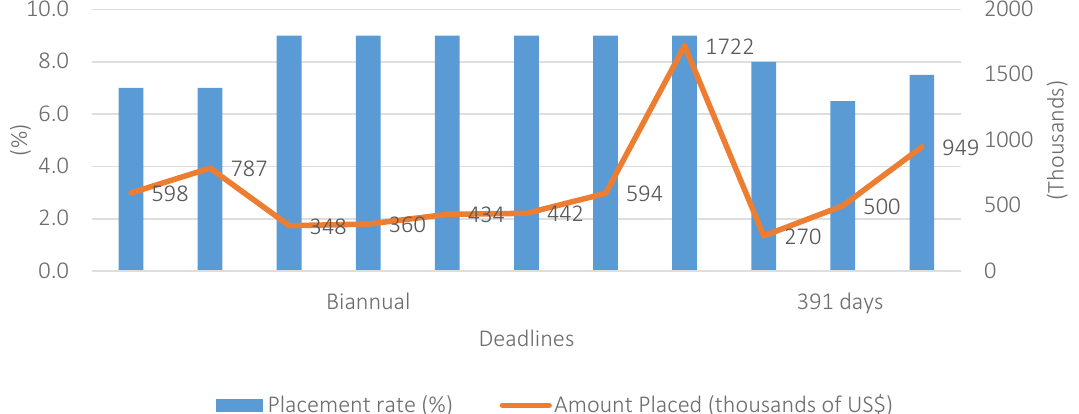
Figure 2. Predisposition in issuance and placement of short-term